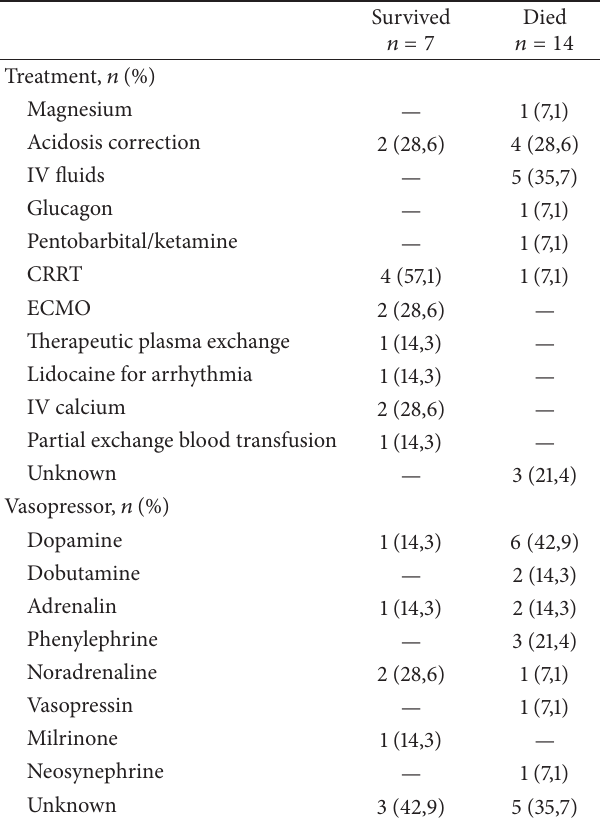
Table 2: Treatment and